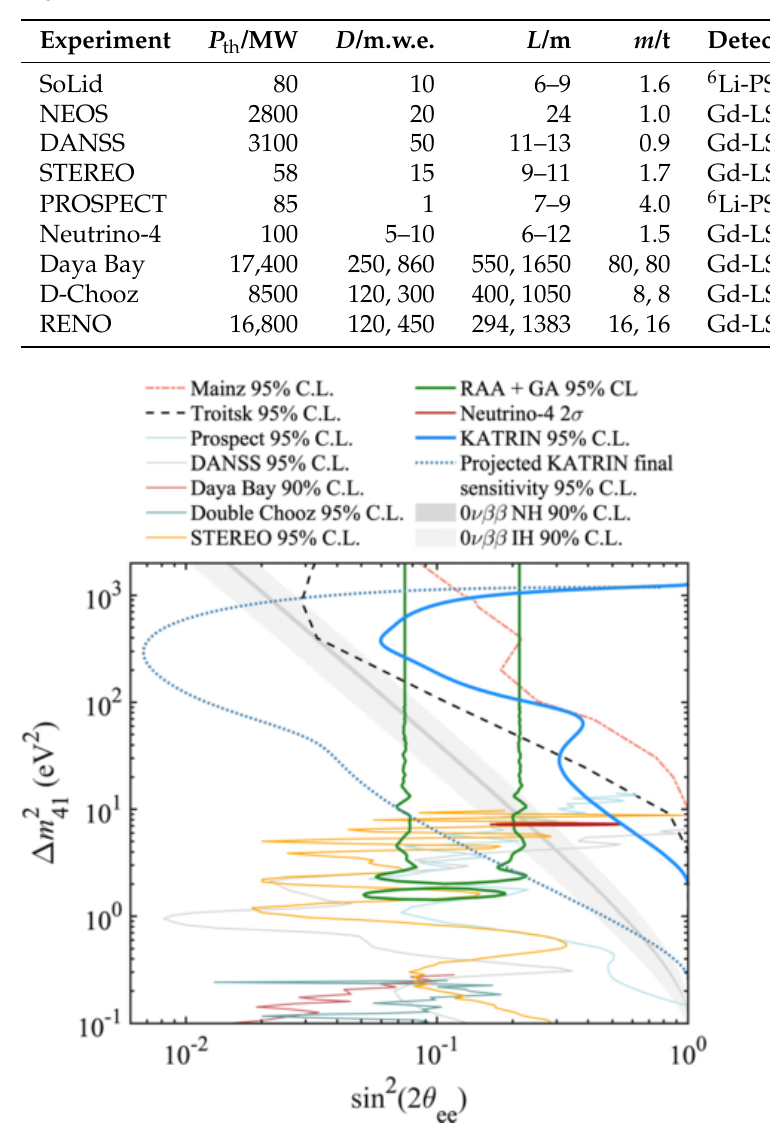
(cid:2) (cid:3) sin 2 ( 2 θ ee ) , ∆ m 2 alongside 41